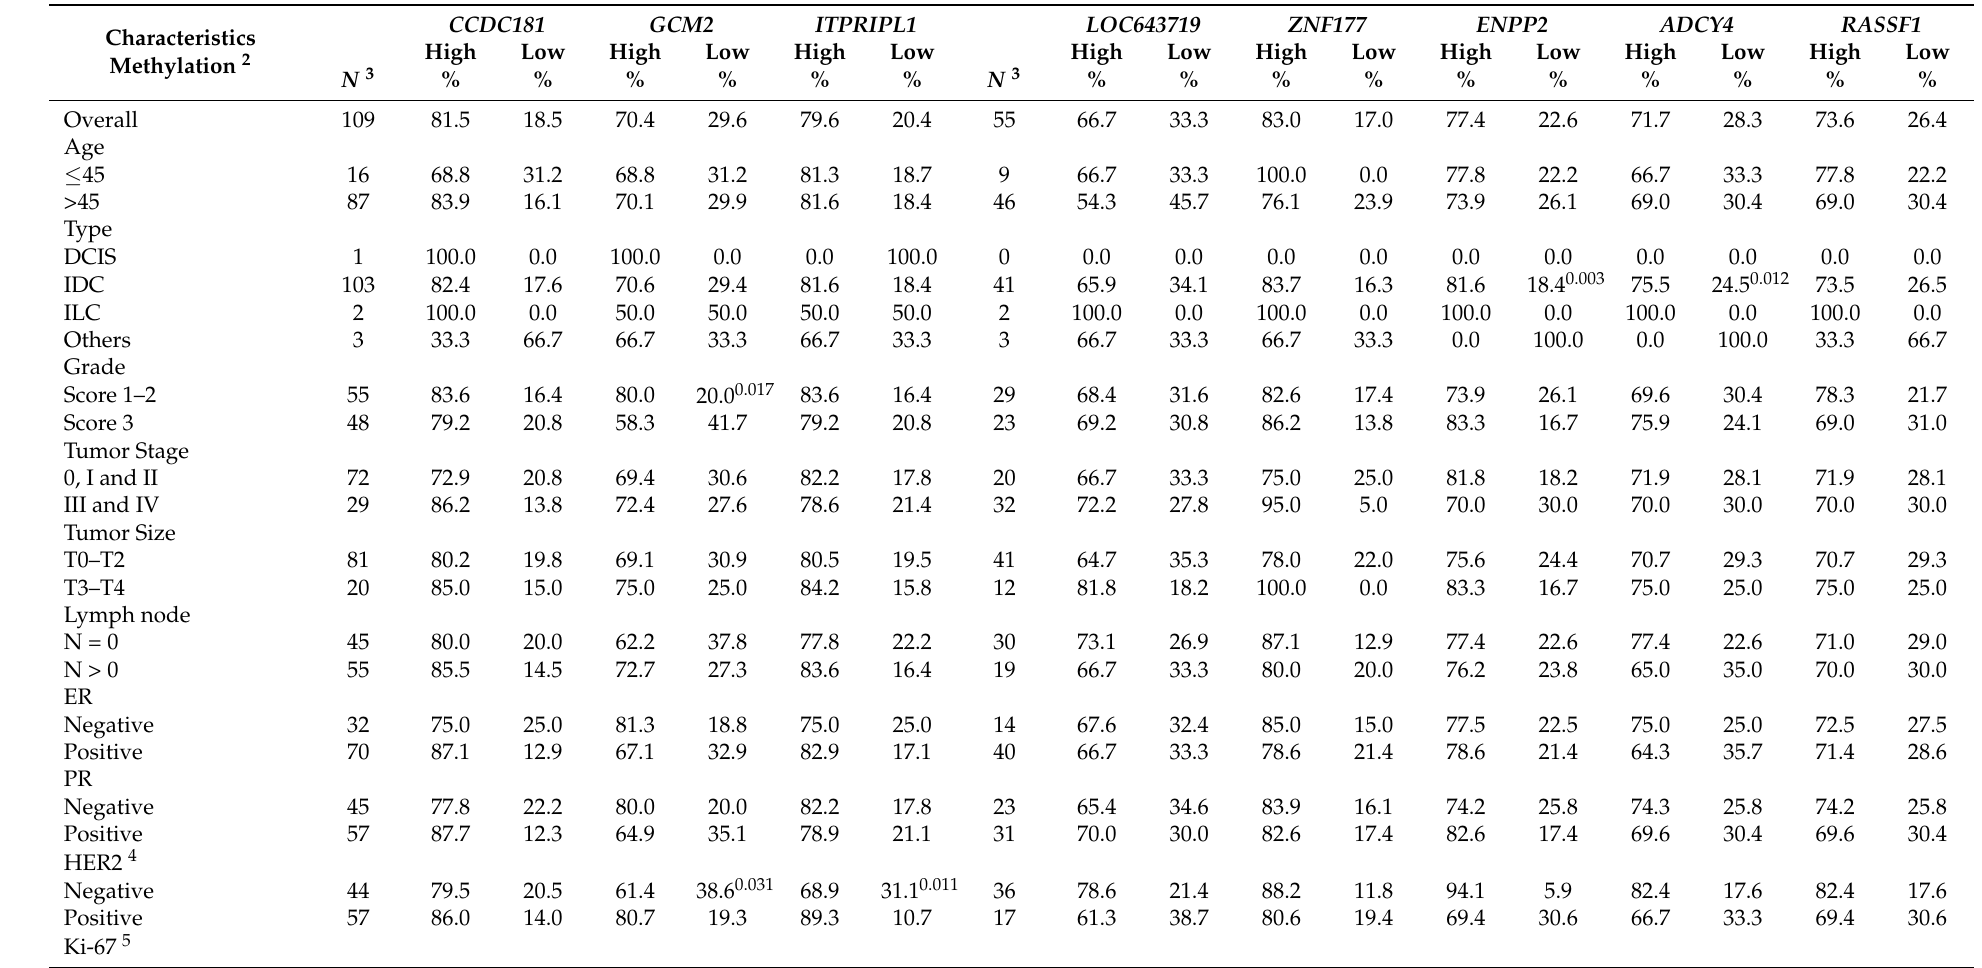
Table 1. Candidate gene promoter methylation in relation to clinical parameters in tumors of Taiwanese breast cancer 1